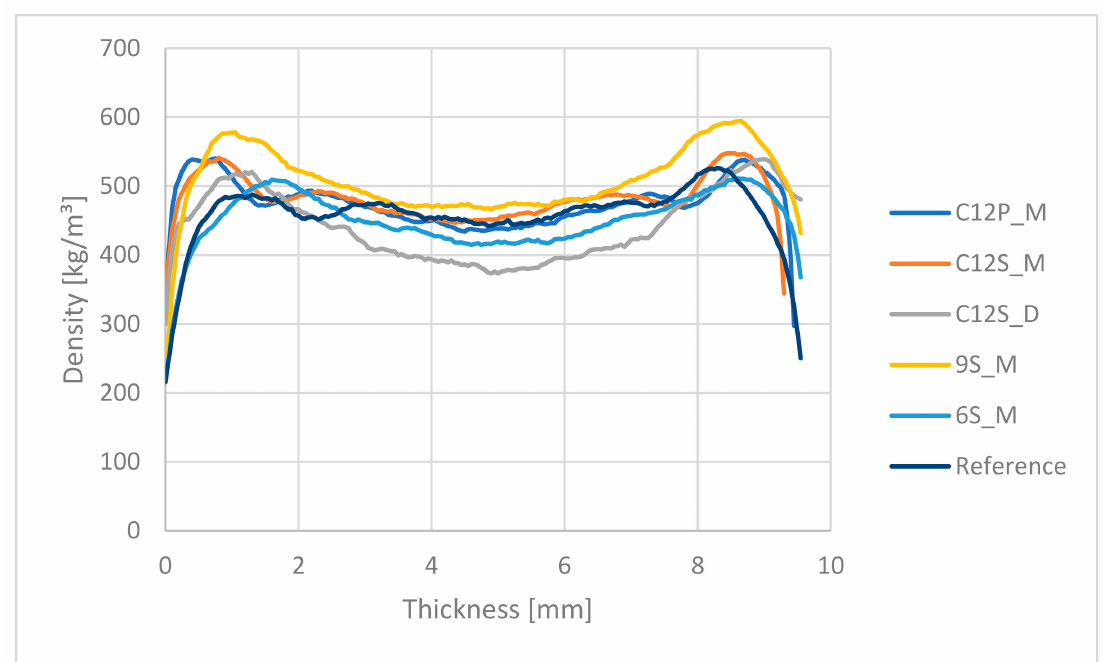
Figure 6. Density profile of the one-layer panels with PS and wood